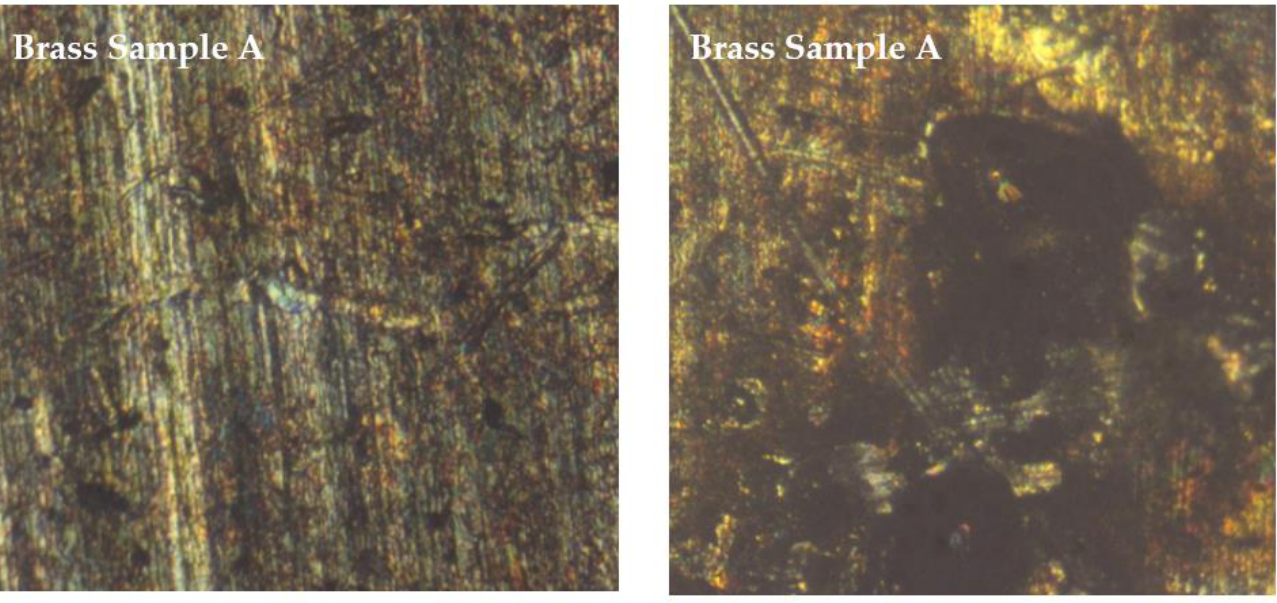
Figure 9. The brass contact surface. ( a ) The new brass contact surface under a microscope. ( b ) The same brass contact surface after being subjected to an electrical arc from normal contact. The current that passed through the contact was 4 A. Note that brass surface leech others copper contact and form bulges of oxides on the surface.